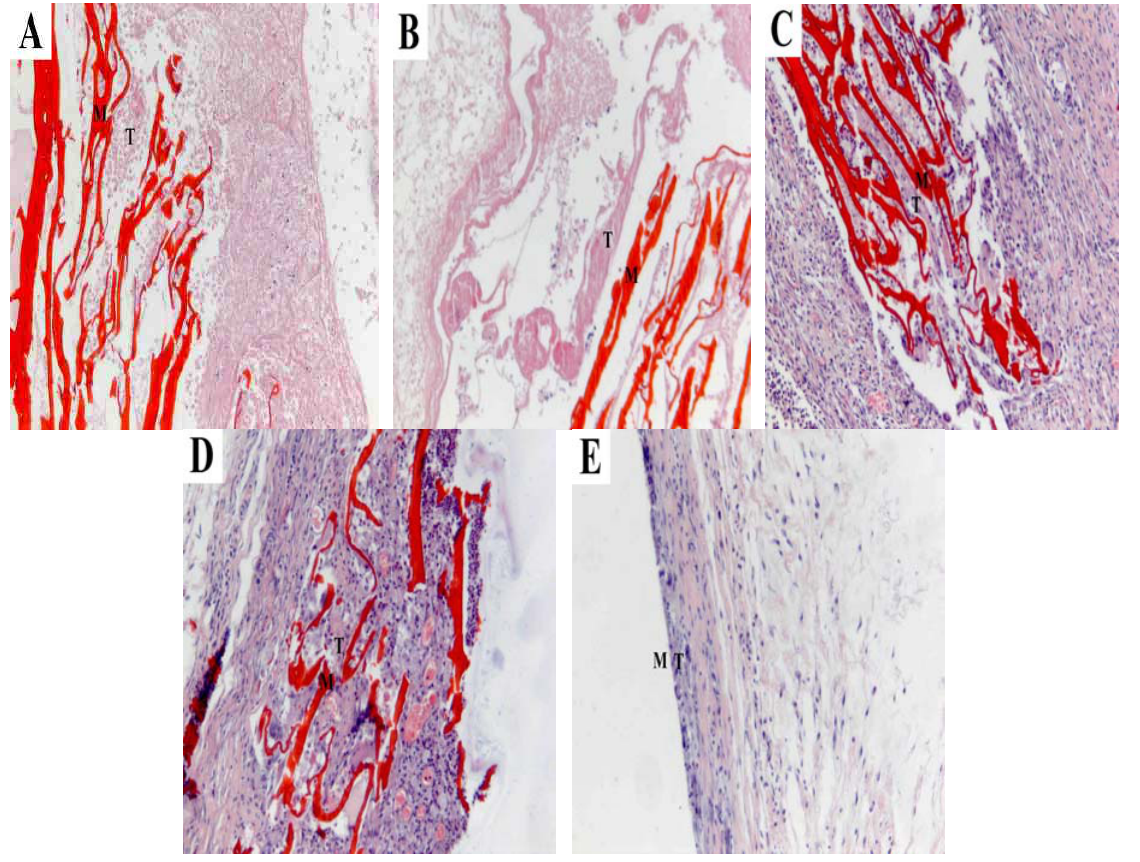
implantation ( A ) CS; ( B ) PCLA- Ι ; ( C ) PCLA- ΙΙ ; ( D ) PCLA- ΙΙΙ ; ( E ) PLA.M stand for materials and T stand for tissues